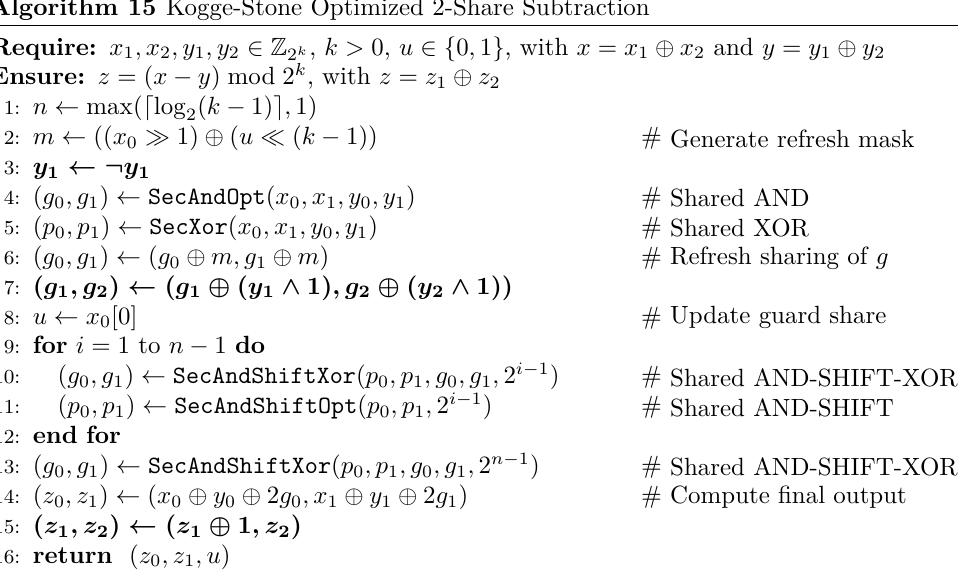
Algorithm 15 Kogge-Stone Optimized 2-Share